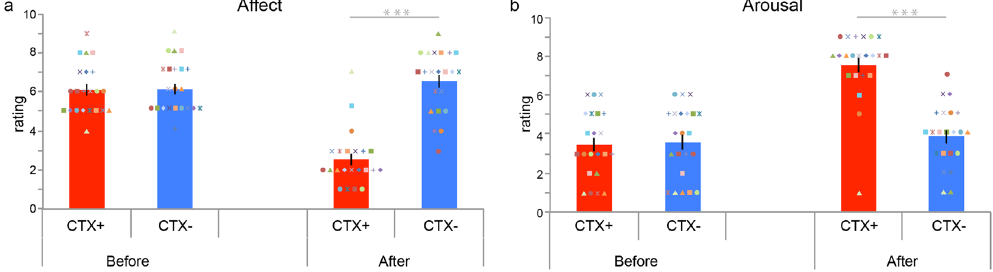
Figure 2. Context conditioning in iVR results in acquisition of subjective threat. Bar plots reflecting mean affect and arousal ratings before and after context conditioning for the threat (CTX + , red) and safe context (CTX − , blue). Context conditioning resulted in more negative affect ratings ( a ) and higher arousal ratings ( b ) for the threat context but did not affect ratings for the safe context. Error bars = s.e.m. Coloured geometrical shapes represent individual data-points. *** p <